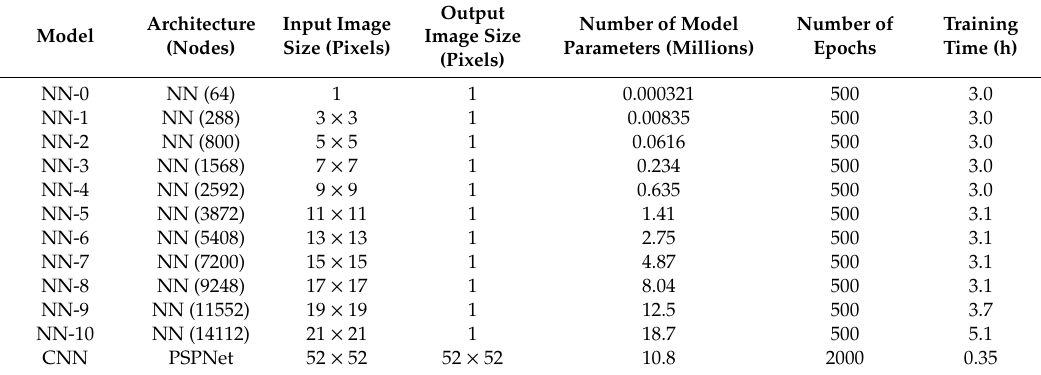
Table 1. Tested neural network (NN) architectures for the estimation of cloud optical thickness (COT) from zenith-viewing transmitted radiance. Single-pixel (NN-0) and multi-pixel (NN- M for M = 1–10) architectures derive a single-pixel COT of the central pixel from single-pixel and multiple pixels’ radiance data. CNN denotes convolutional NN, which derives the multi-pixel COT from multiple pixels’ radiance data. The input image corresponds to the surrounding pixels used to derive COT at either the single central pixel in NN- M , or the whole image at once in